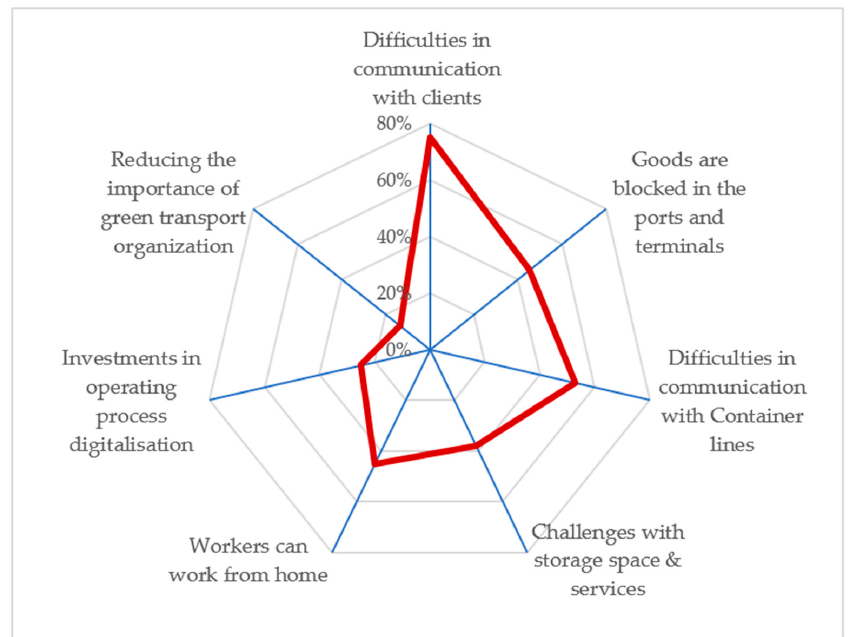
Figure 5. The share of companies experiencing changes in key work areas of more than 30% com- pared to the period before the COVID-19